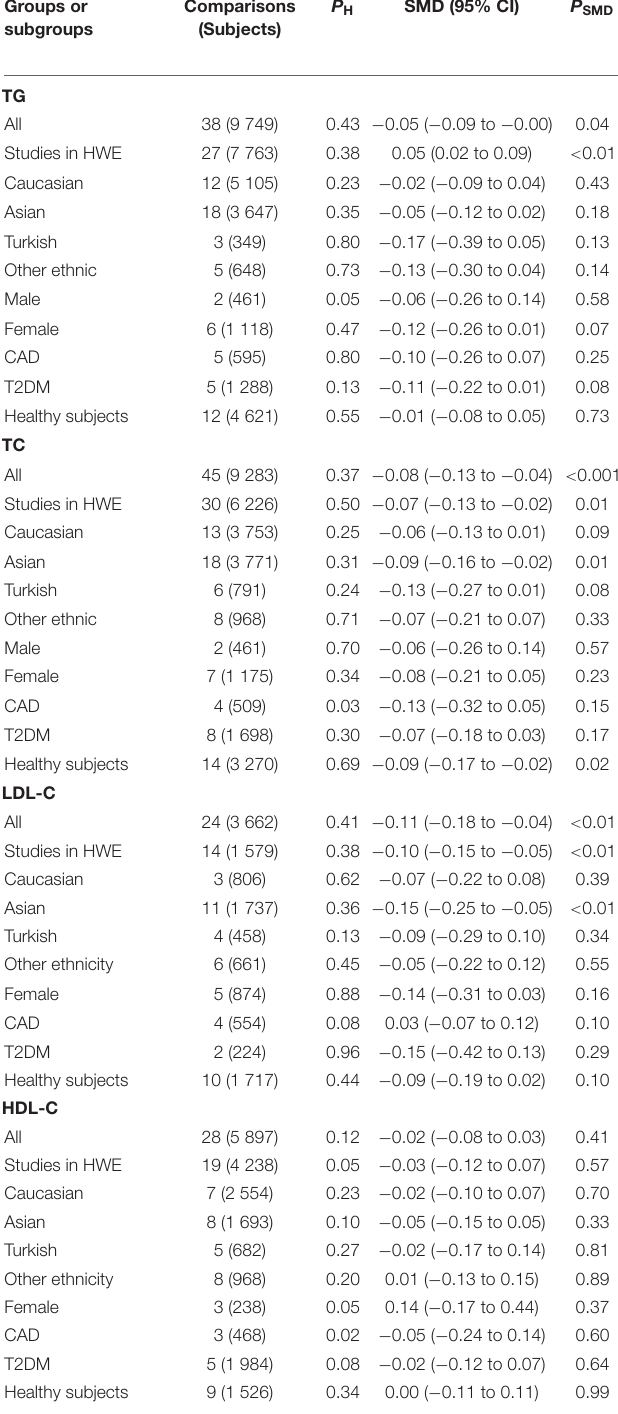
TABLE 2 | Meta-analysis of SERPINE1 rs1799889 polymorphism with lipid levels (after eliminating the studies with heterogeneity). Groups or